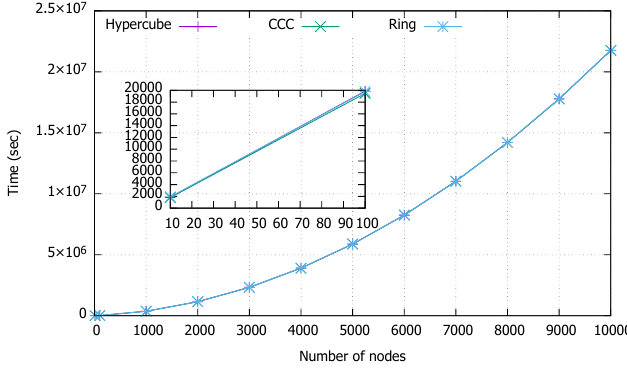
Figure 6. The comparison of control traffic for different overlay topologies, using